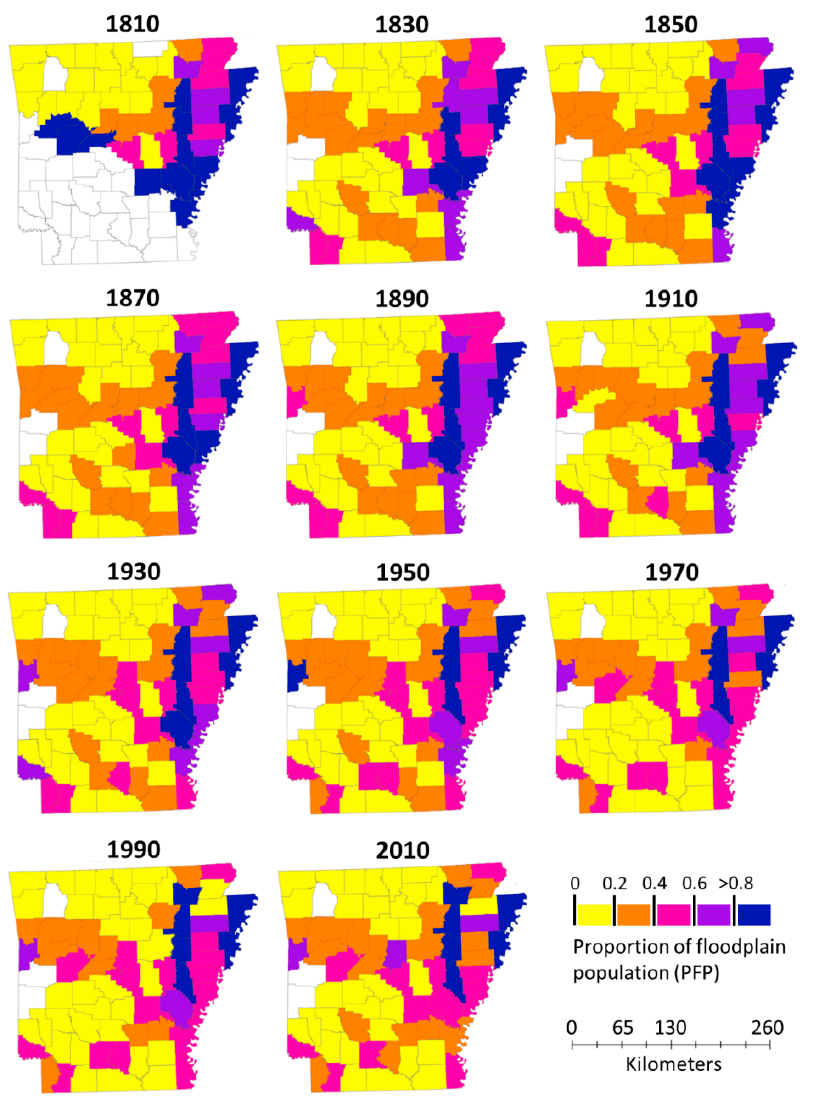
Figure 5. Proportion of floodplain population for the state of Arkansas starting from 1810. (See Figure S2 in Supplementary Materials for PFP for the state of Arkansas in 10-year intervals).